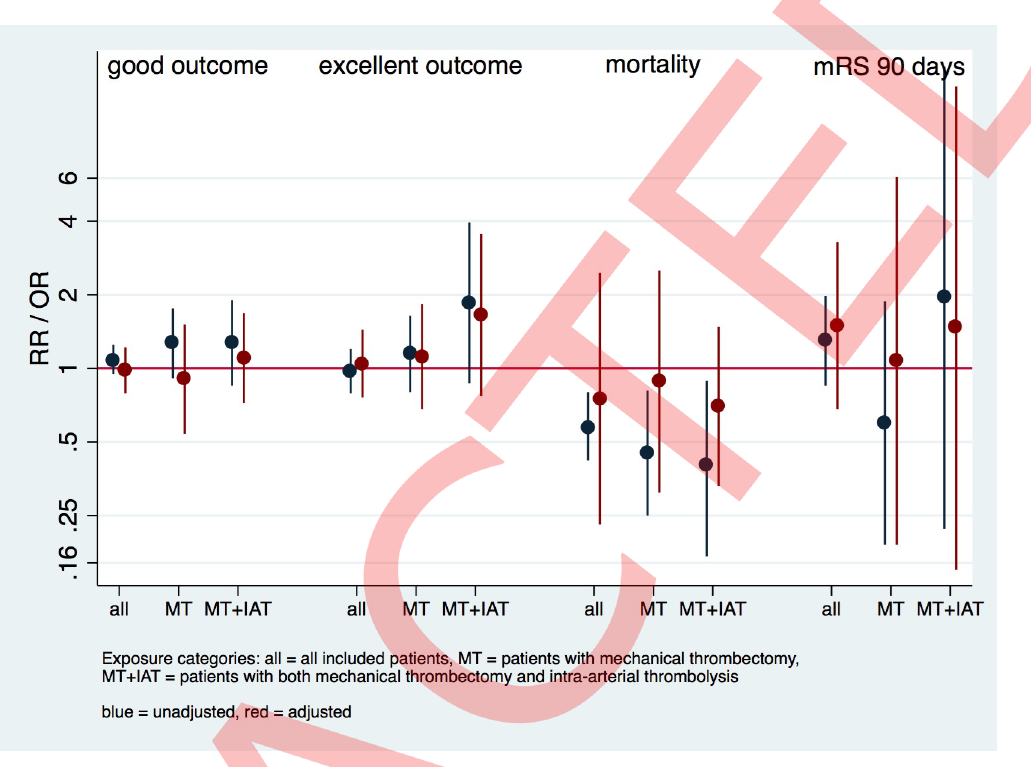
Fig 1. Regression analysis of primary endpoints according to mode of therapy. Models were adjusted for the following covariates: age, sex, hypertension, atrial fibrillation, baseline NIHSS, and time to endovascular treatment.